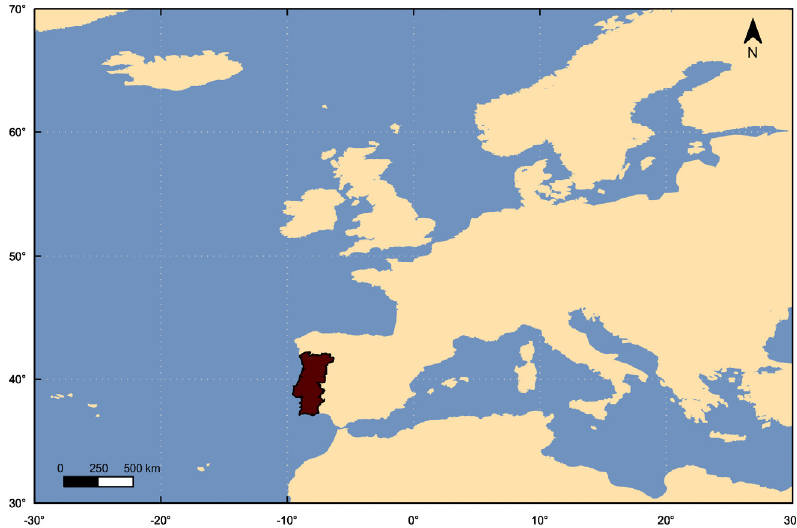
Figure 1. Location of the study area, continental Portugal, in the context of Europe and the North Atlantic. The axes indicate latitude (YY) and longitude (XX) coordinates.